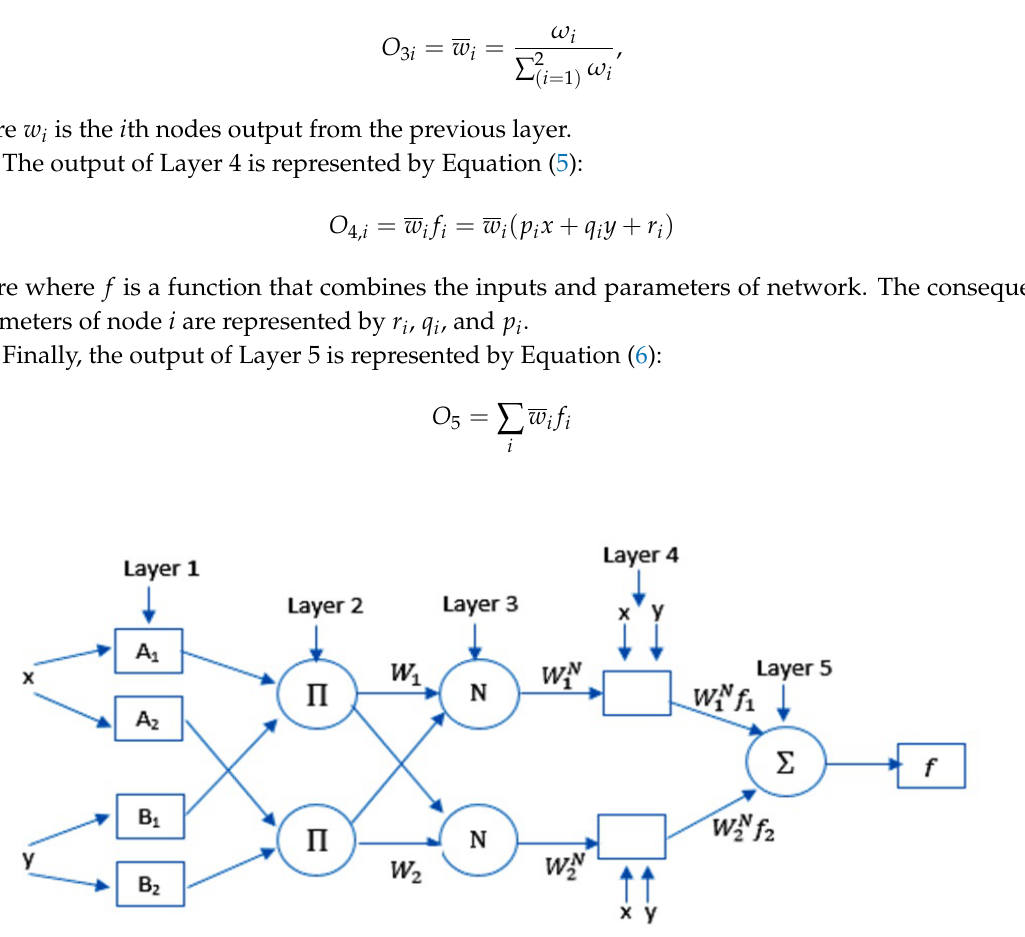
Figure 1. The basic structure of the ANFIS